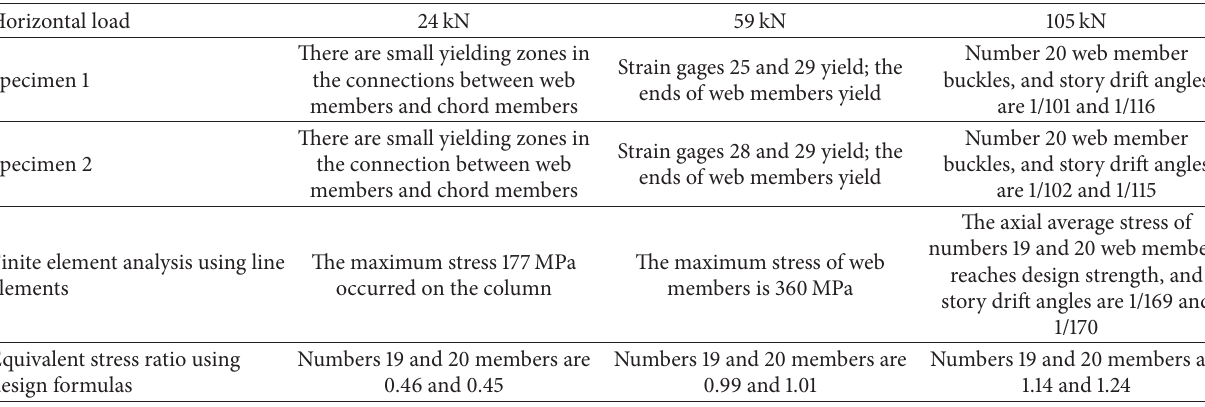
Table 4: Comparison of mechanical performance under three load